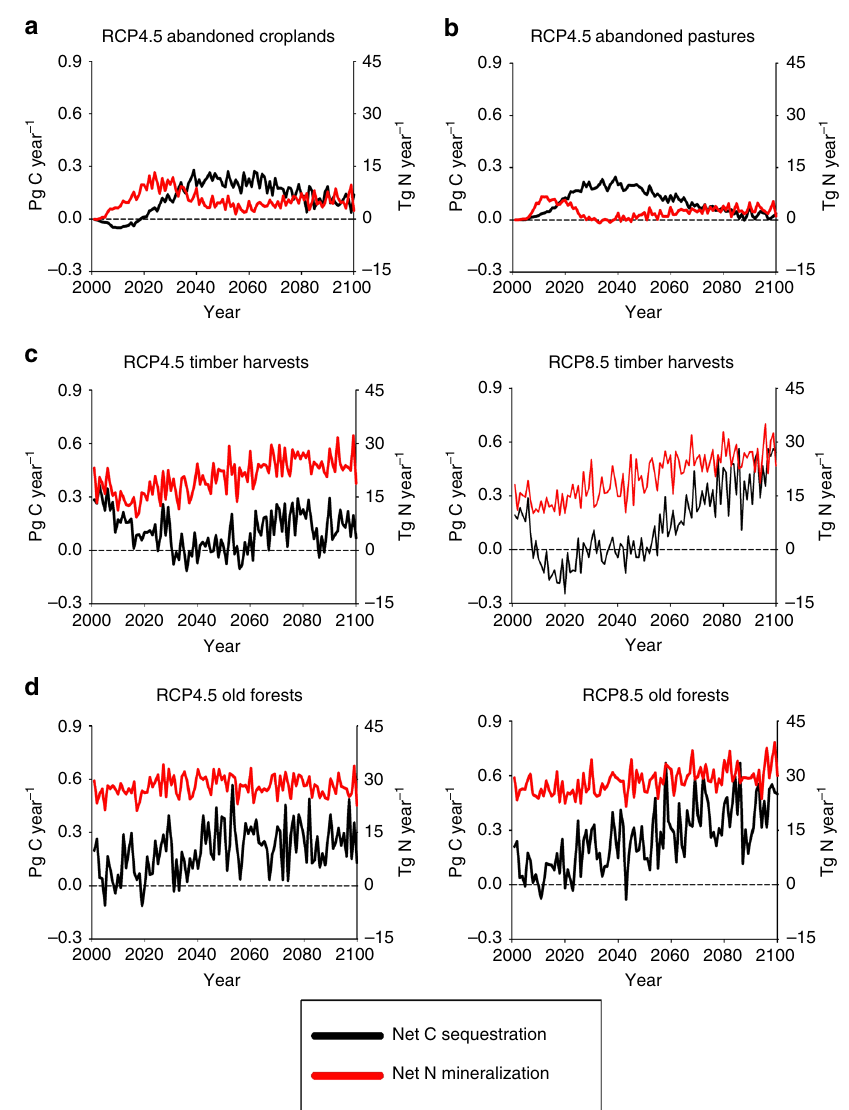
Fig. 6 In fl uence of global change on forest C sequestration and net N mineralization. a Secondary forests on abandoned croplands under the RCP4.5 scenario. b Secondary forests on abandoned pastures under the RCP4.5 scenario. c Secondary forests recovering from timber harvest under the RCP4.5 and RCP 8.5 scenarios. d Old forests that have not been disturbed by land-use change during the 21st century under the RCP4.5 and RCP8.5 scenarios. Area of secondary forests on abandoned croplands and abandoned pastures are insigni fi cant under the RCP8.5